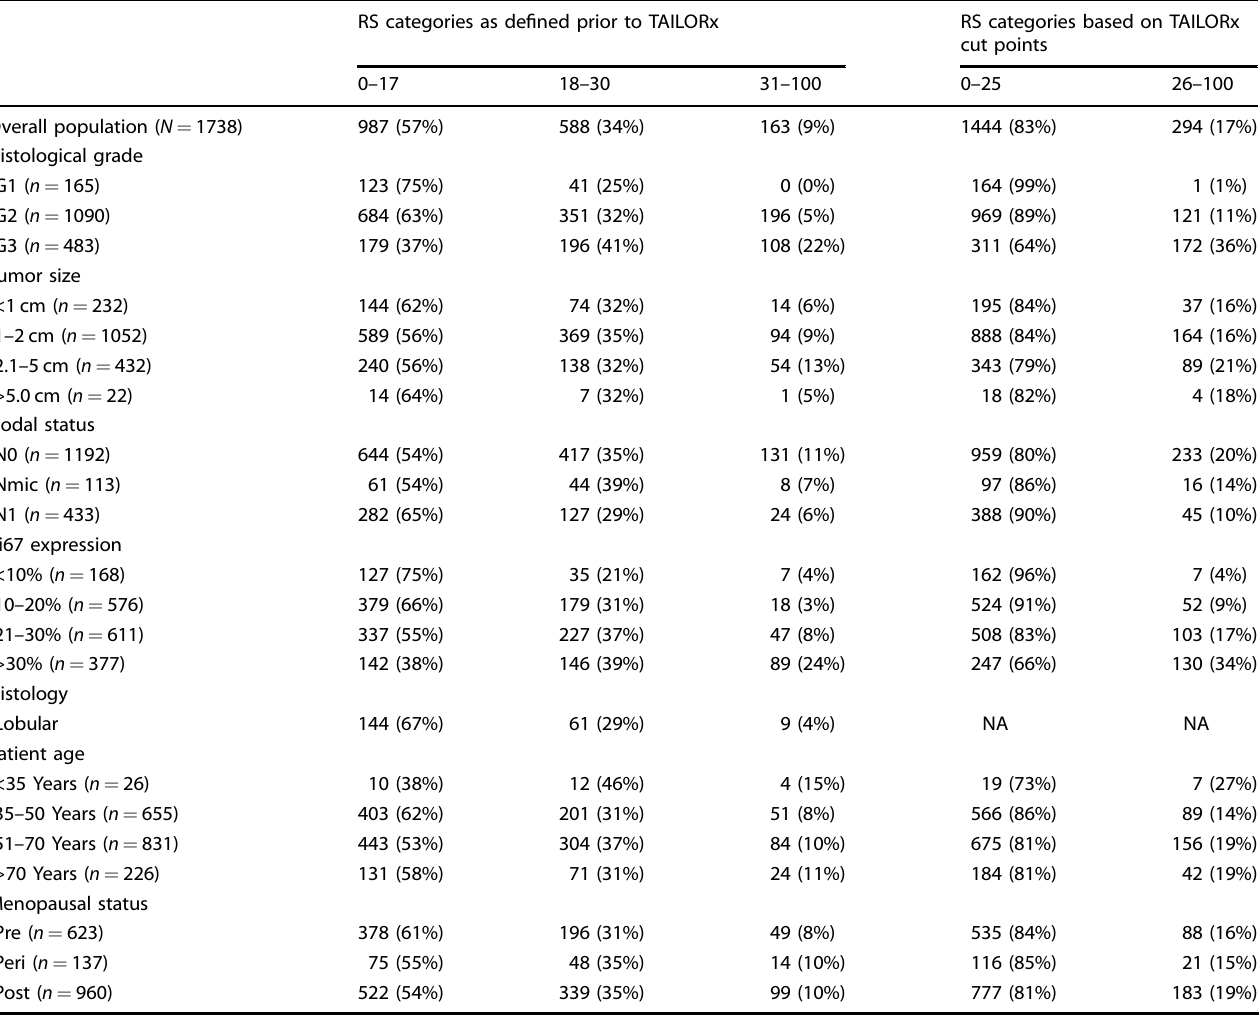
TABLE 2. Oncotype DX Breast Recurrence Score ® results categorized according to RS groups used prior to TAILORx (left) and RS groups based on TAILORx cut points (shaded columns, right).